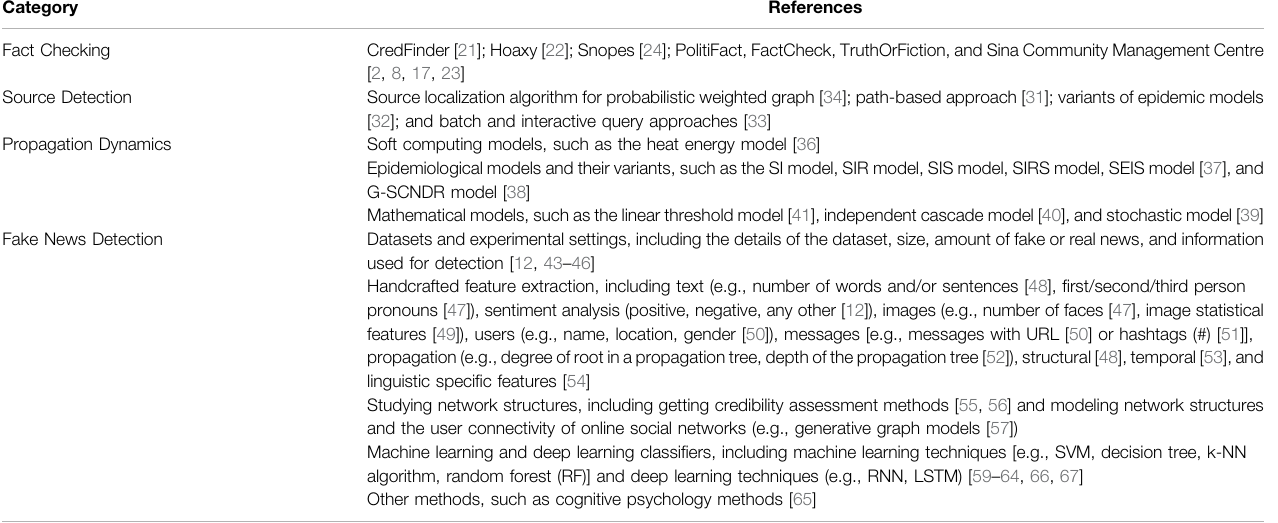
TABLE 1 | Summary of some previous work related to debunking fake